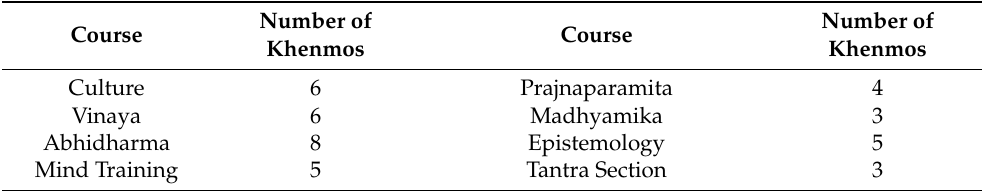
Table 5. The number of Khenmos who taught the main formal courses in 2017 38